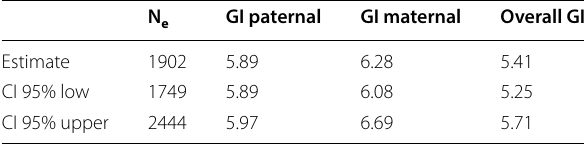
Table 2 Estimates of generation effective size (N and generation interval (GI) for N. norvegicus sampled